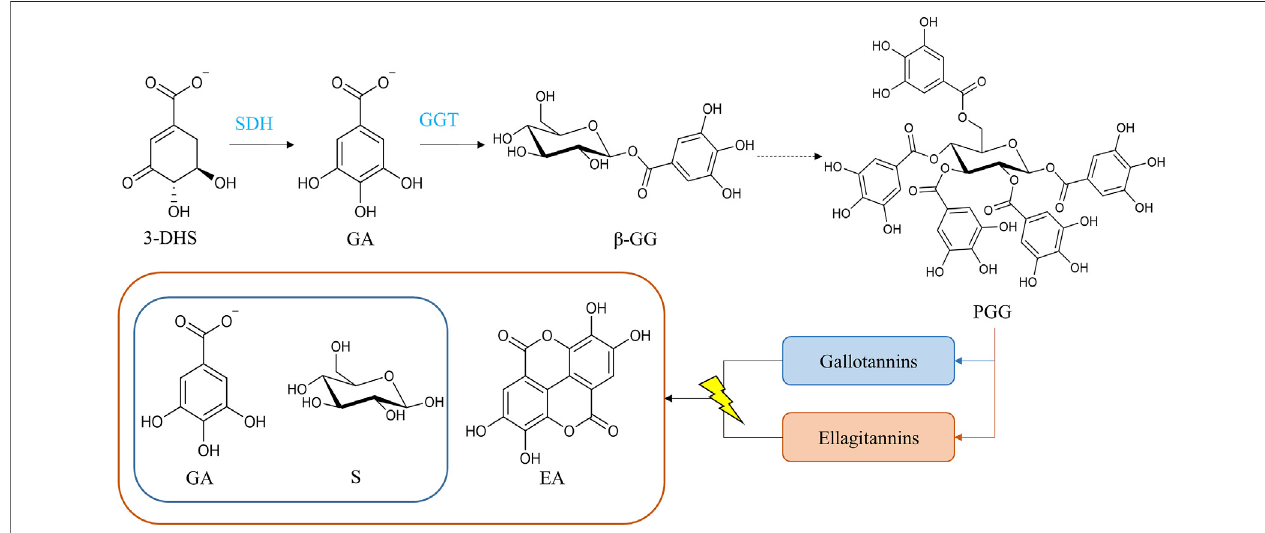
FIGURE 5 | Biosynthetic pathway of hydrolysable tannins. The hydrolysis of gallotannins and ellagitannins yields gallic acid and sugar (glucose represented) and gallic acid, ellagic acid, and sugar, respectively. Dotted lines represent multistep reactions. Abbreviations: 3-dehydroshikimate (3-DHS), gallic acid (GA), sugar unit (S), ellagic acid (EA), β -glucogallin ( β -GG), pentagalloylglucose (PGG), shikimate dehydrogenase (SDH), and β -glucogallin-dependent galloyltransferases